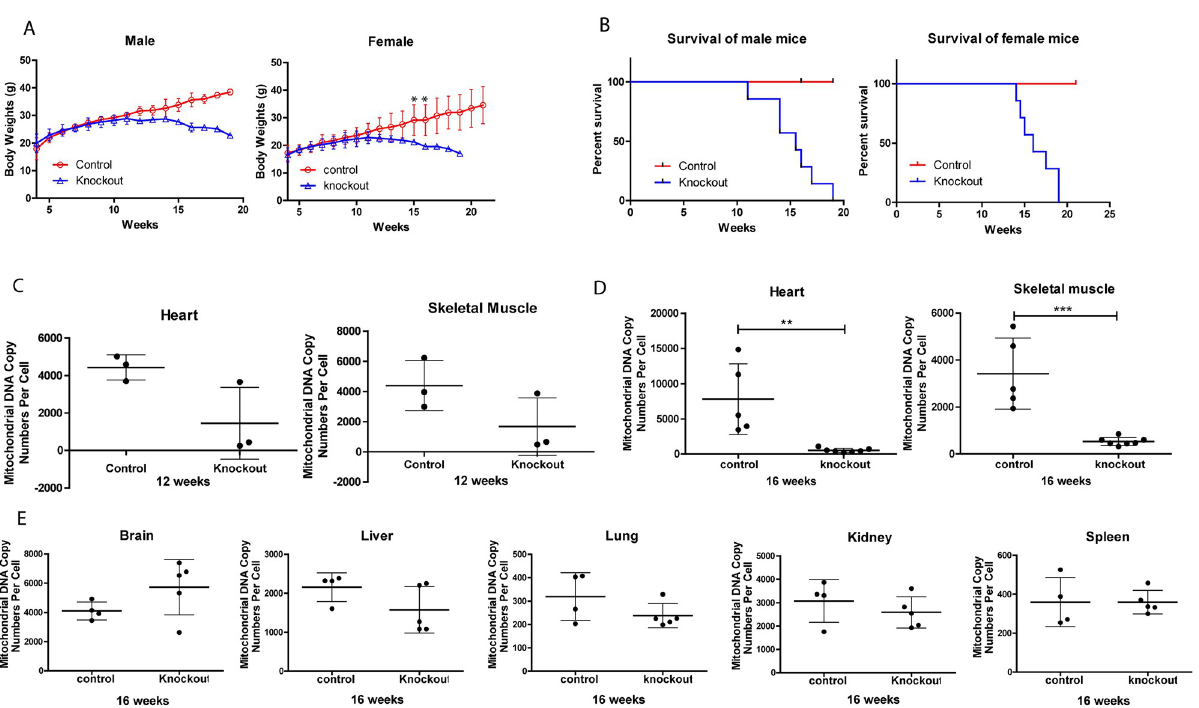
Fig 1. Life expectancy, body weight and mtDNA copy number. (A) Weight of male and female mice between 4 and 20 weeks of age. n = 3 mice per group of male, and n = 5 mice per group of female. (B) Life span of male and female mice between 4 and 20 weeks of age. n = 7 mice per group. (C) mtDNA copy number of 12 weeks mice heart and skeletal muscle. (D) 16ax weeks heart and skeletal muscle. (E) Other important organs in 16 weeks mice did not show mtDNA deficiency symptom. Data are shown as means ± S.D. For (C-E), n = 3–8 mice per group. For (A,C-E), groups were compared using the Mann-Whitney U -test. Significant levels were set to p < 0.05( � ), p < 0.01( �� ), p < 0.001( ��� ).